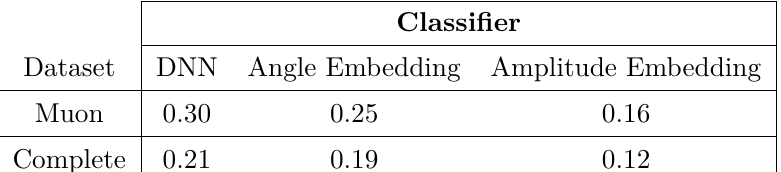
Figure 6. Probability distributions for jet tagged to (blue) b and (yellow)